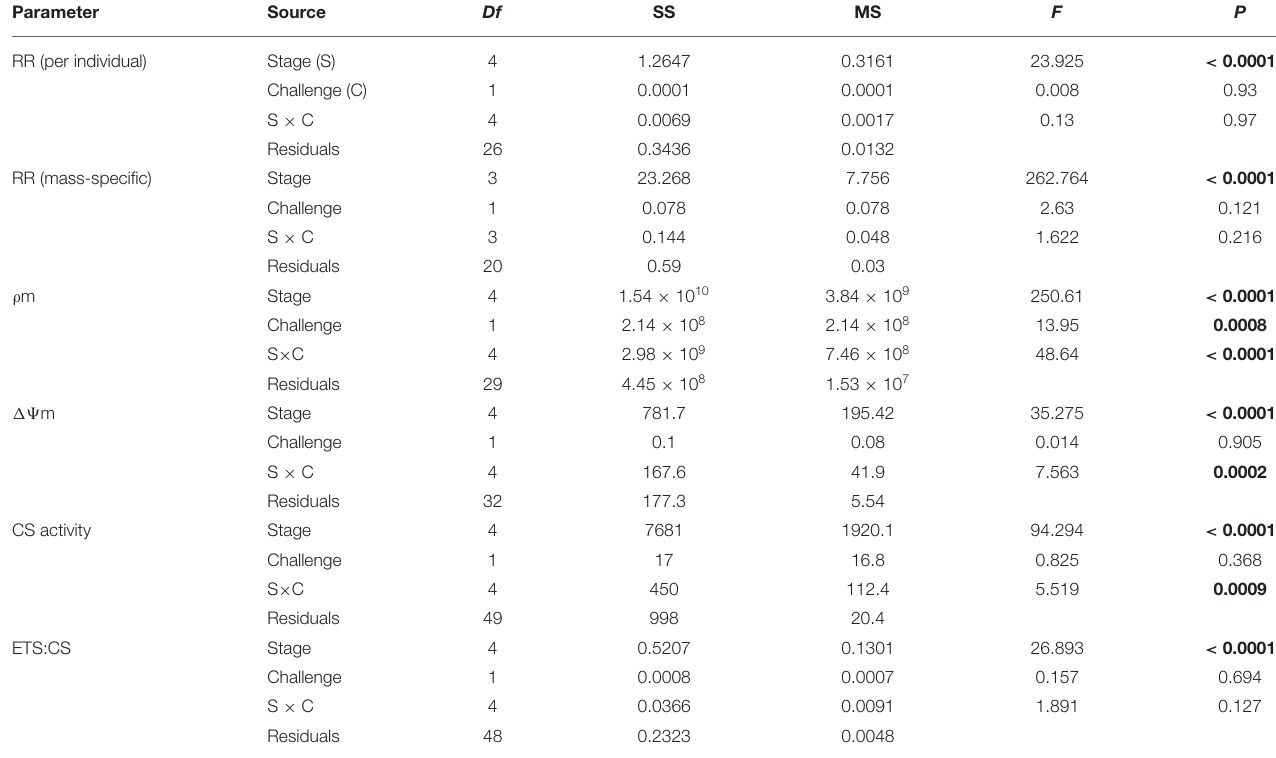
TABLE 2 | Two-Way ANOVAs evaluating the effect of the developmental stage and the bacterial challenge on respiration rates (RR), mitochondrial density ( ρ m), mitochondrial membrane potential ( 19 m), citrate synthase activity (CS), and ETS:CS ratio throughout larval development and in early juveniles from the scallop Argopecten purpuratus